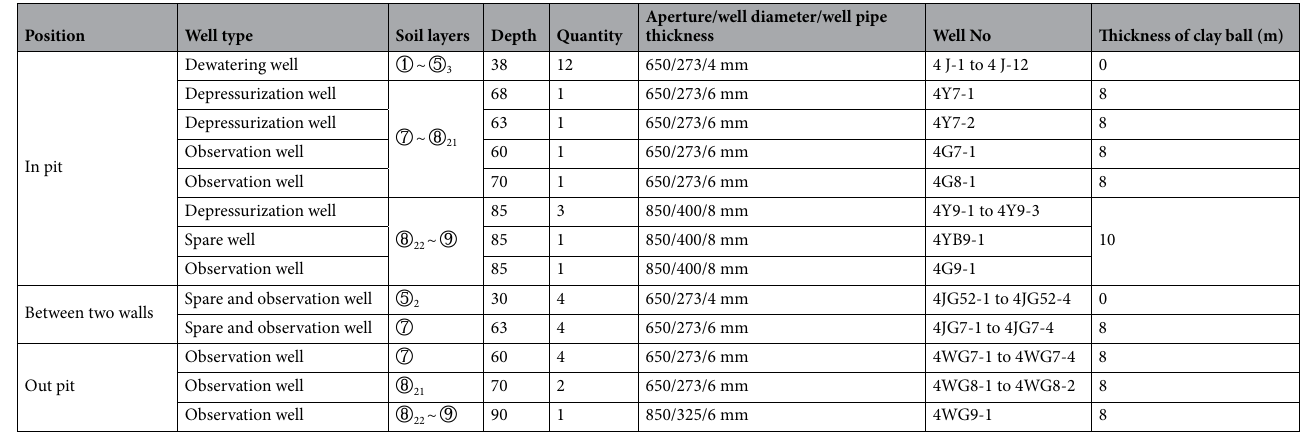
Table 2. Statistical table for the layout of dewatering wells in foundation